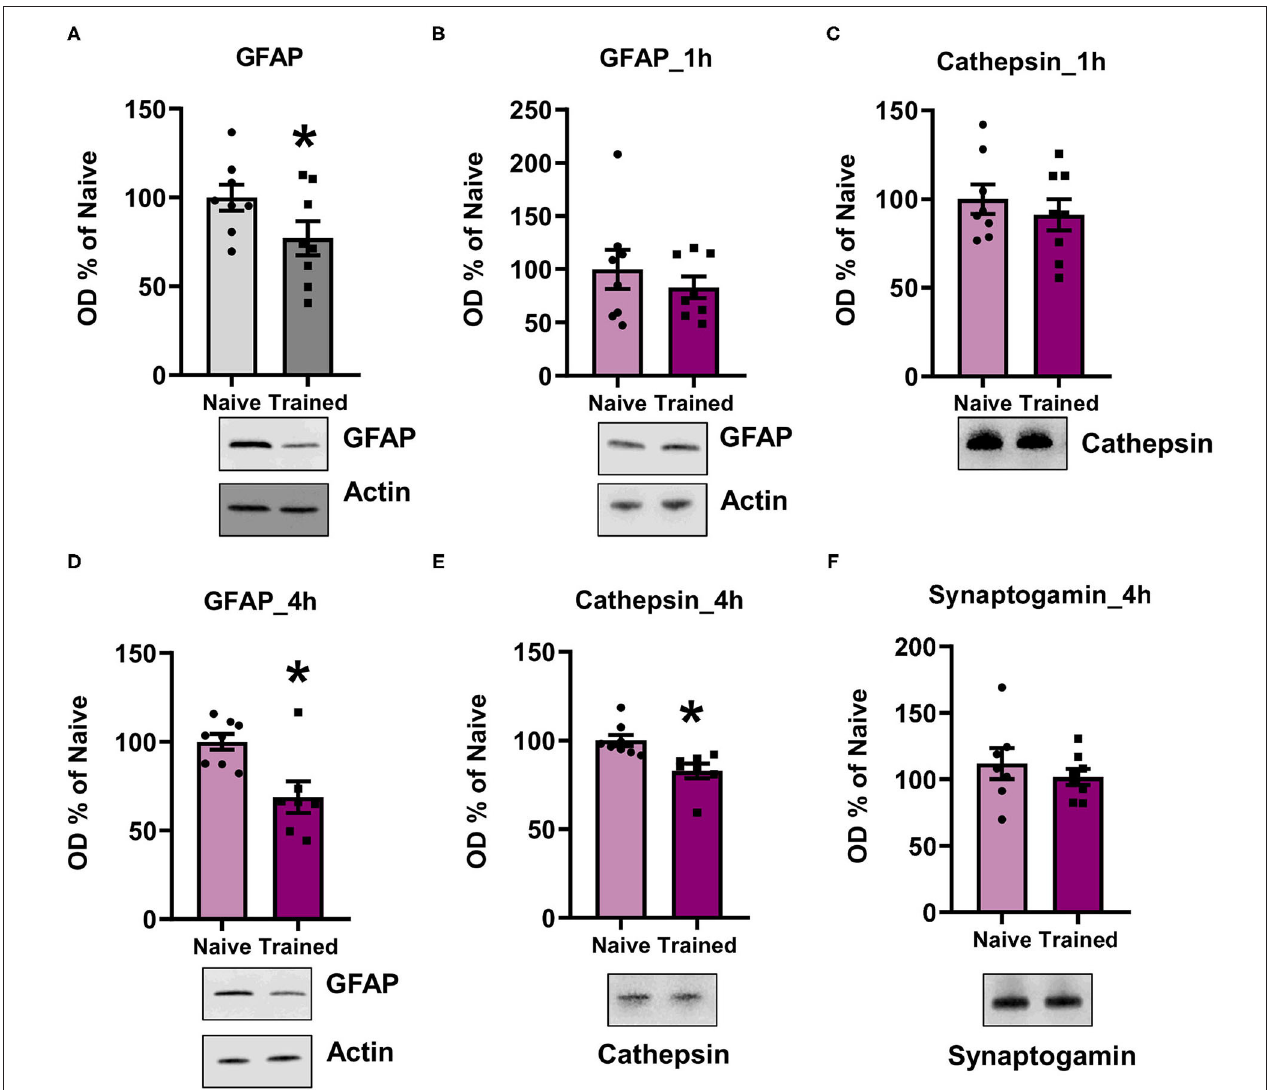
FIGURE 6 | K48 polyubiquitination targets substrates for degradation in both males and females during fear memory formation. (A,B) In males (A) but not females (B) , GFAP levels were decreased in the basolateral amygdala (BLA) 1 h after contextual fear conditioning ( n = 8 per group per sex). (C) Cathespin-D levels did not change in the BLA of females 1 h after contextual fear conditioning. (D–F) In females, GFAP (D) and Cathespin-D (E) , but not synaptogamin (F) , levels were decreased in the BLA 4 h after contextual fear conditioning ( n = 7–8 per group). * P < 0.05 from Naïve.